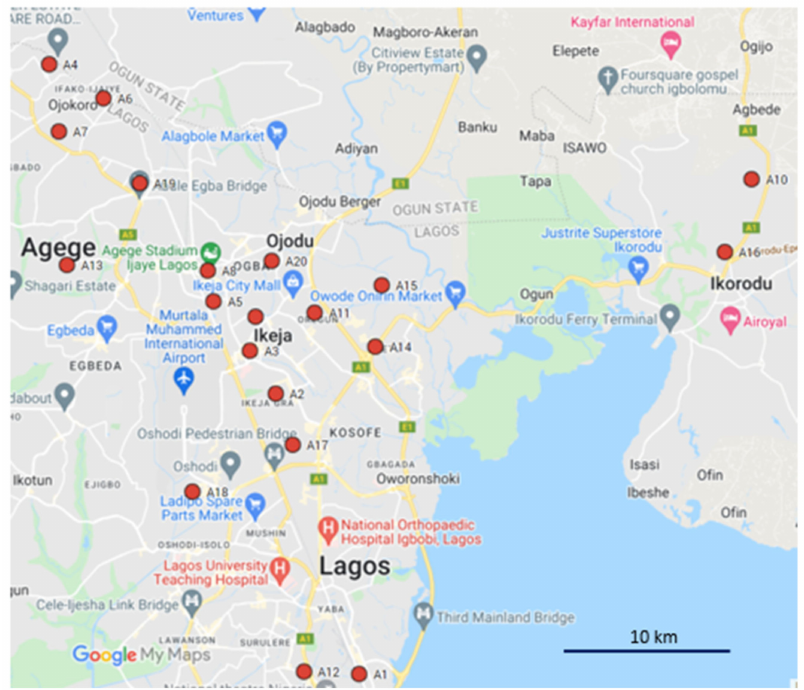
Figure 1. Map of the Lagos area showing sampling points (prepared using Google Maps). On arrival, the soil samples were air-dried for 14 days, and then sieved through a 2 mm nylon mesh sieve before grinding and homogenization with mortar and pestle.